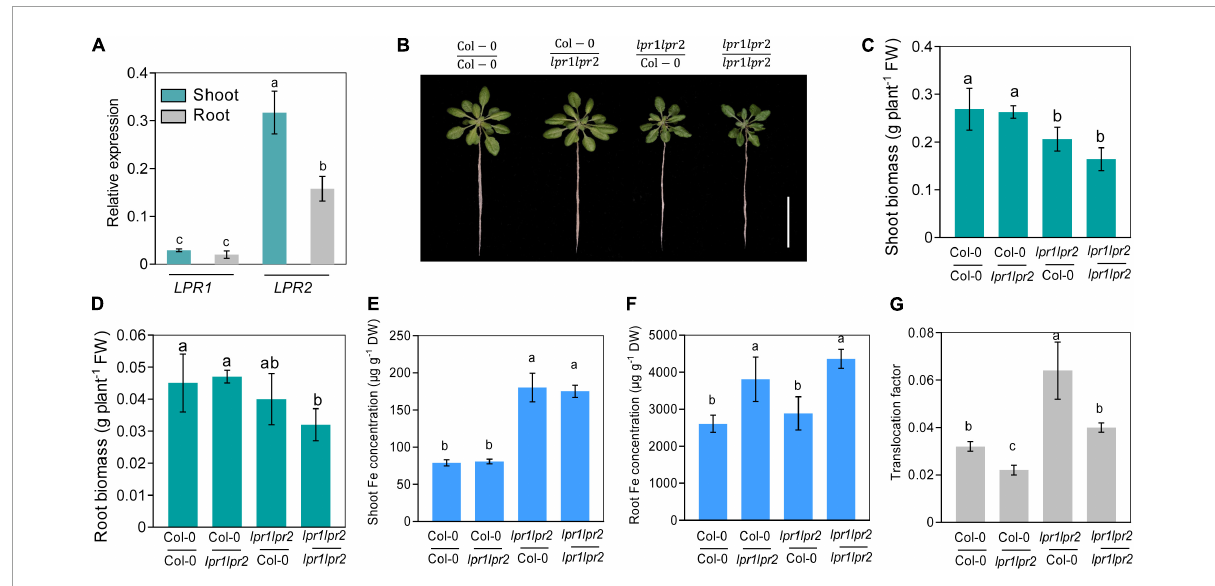
FIGURE3 Shoot and root LPRs, respectively, involve in affecting Fe nutrition and growth in their corresponding tissues. (A) Gene expression of low phosphate root 1 (LPR1) and low phosphate root 2 (LPR2) in shoots and roots. EF1 α and UBQ10 were used as the internal control. (B) The phenotypes of different grafted plants. Col-0/Col-0 and lpr1lpr2 / lpr1lpr2 were self-grafted plants; Col-0/ lpr1lpr2 was grafted plants with Col-0 as shoot scion and lpr1lpr2 as rootstock; lpr1lpr2 /Col-0 was grafted plants with lpr1lpr2 as shoot scion and Col-0 as rootstock. (C,D) Comparison of shoot fresh biomass and root fresh biomass between different grafted plants. (E,F) Fe concentration in shoots and roots between different grafted plants. (G) Translocation factor (TF) of different grafted plants. The grafted plants were photographed and harvested after treating in Fe-sufficient (50 µ M) nutrient solution for 7 days. Translocation factor was calculated as shoot Fe/root Fe. Values are means ± SD of four replicates in panel (A) and five in panels (C–G) . Different letters represent a significant difference at P < 0.05 by Tukey’s test. Scale bars 4